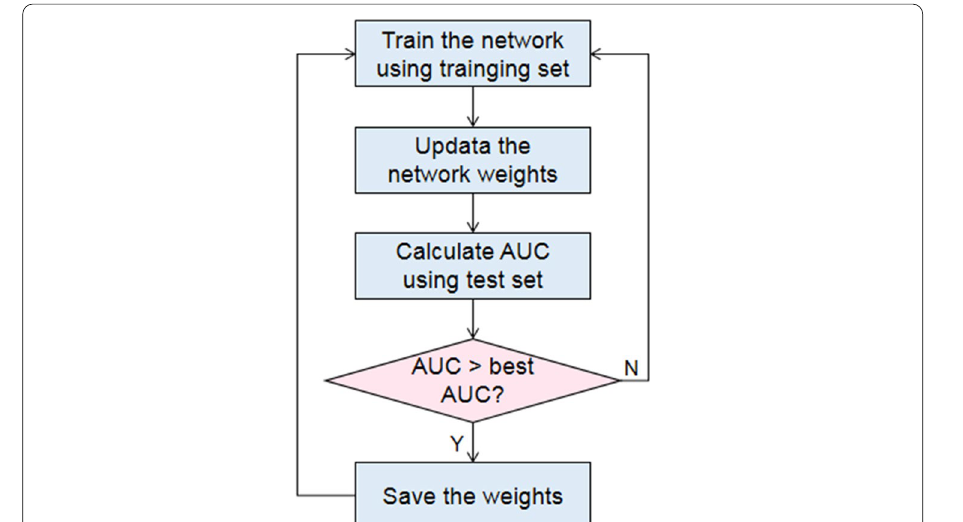
Fig. 2 Network update scheme of original GANomaly. This figure shows the flowchart of the network update